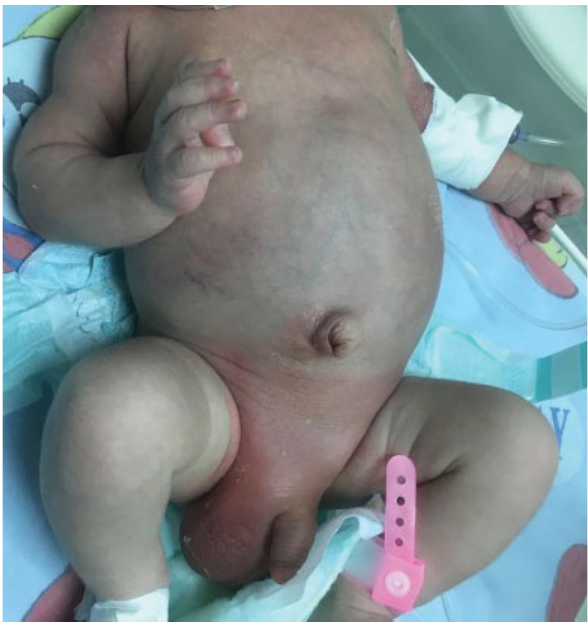
Fig. 1 Neonate presenting with inguinoscrotal erythema and edema.